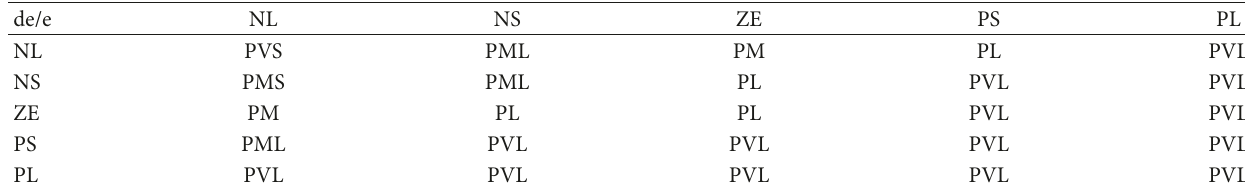
Table 3: Fuzzy rule for 𝑘 𝑑 .